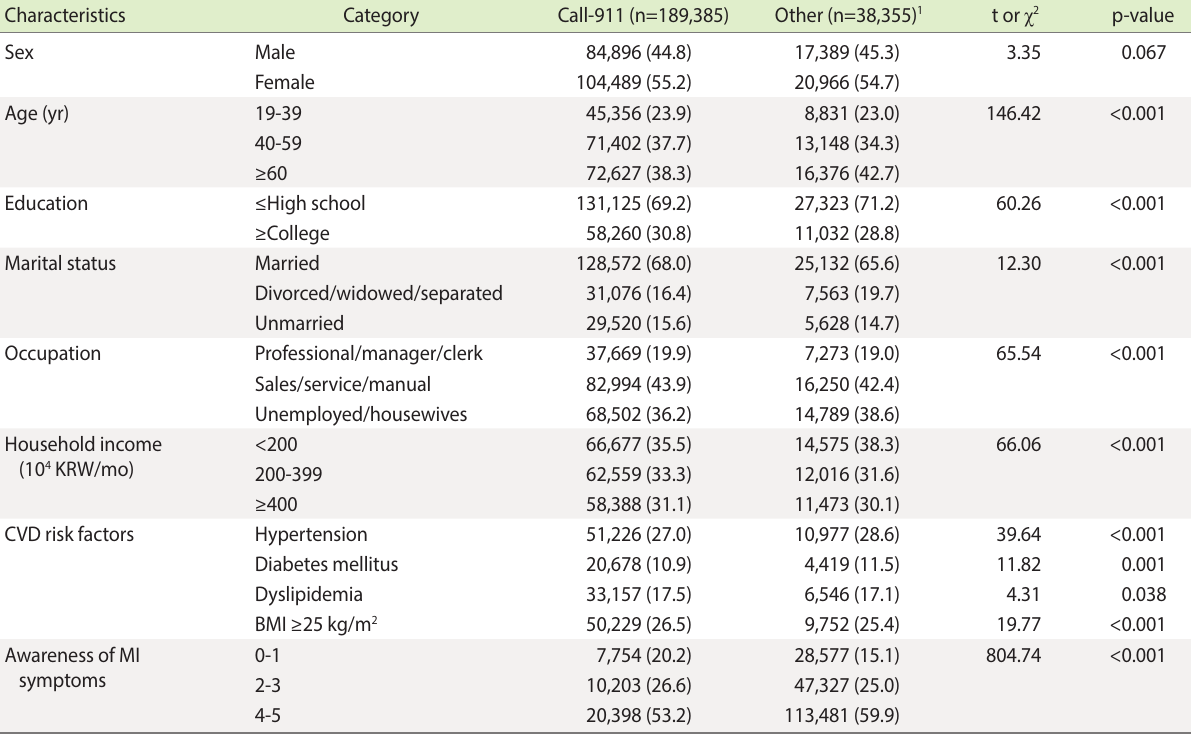
Table 2. Characteristics according to coping behavior at MI onset (n=227,740) Characteristics